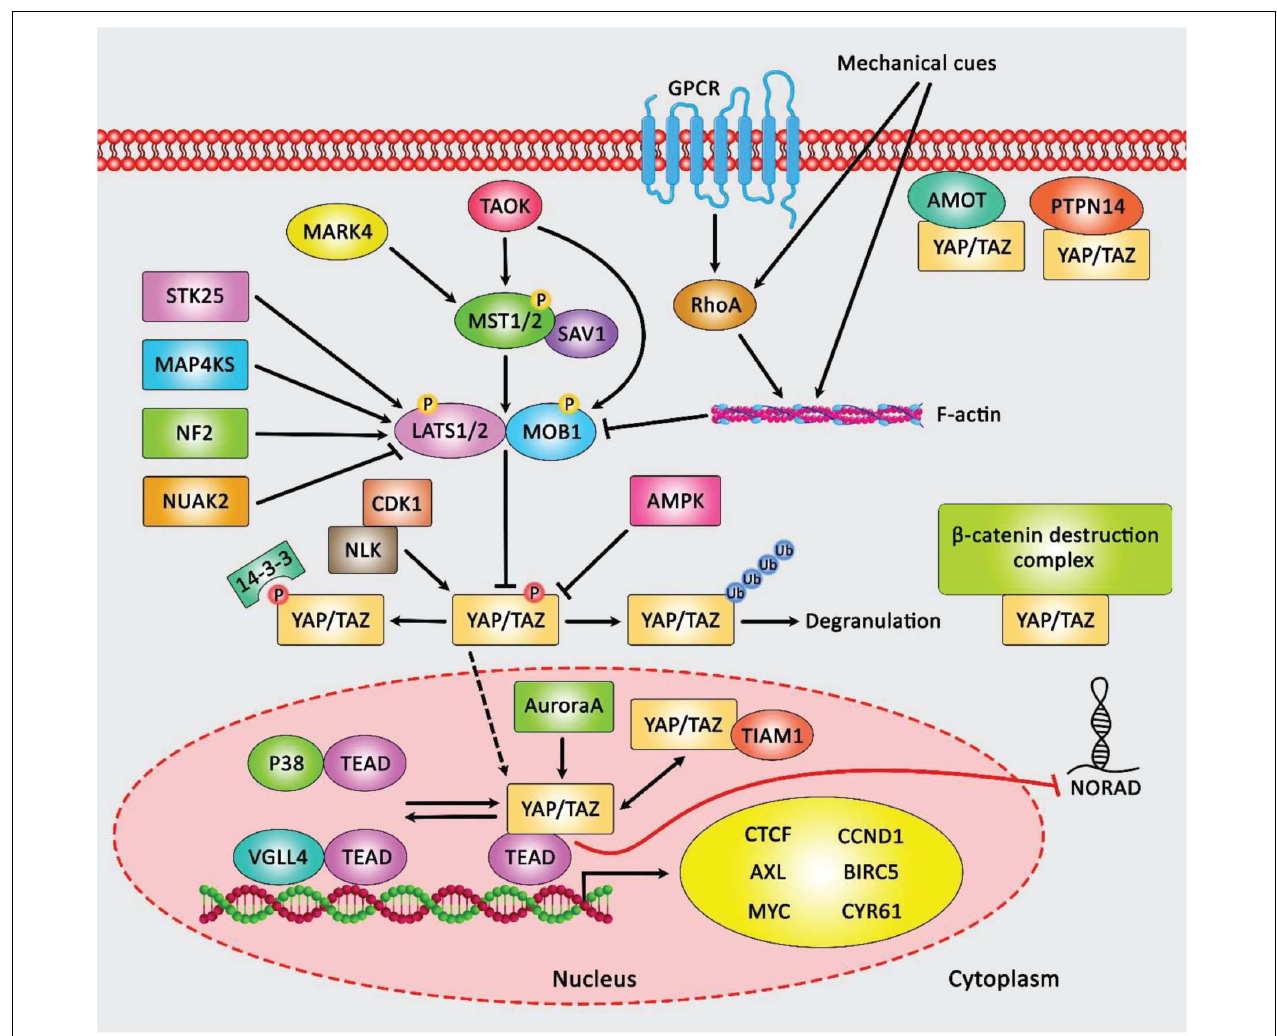
FIGURE 1 | A schematic representation of the crosstalk between Hippo signaling cascade and lncRNA NORAD in lung and breast neoplasms. YAP/TAZ is mainly modulated via the canonical Hippo cascade, MST1/2-SAV1, and LATS1/2-MOB1. LATS1/2 could in turn phosphorylate YAP/TAZ and suppress its function through either ubiquitination and proteasome-mediated degradation or 14-3-3-mediated cytoplasmic sequestration. Unphosphorylated YAP/TAZ is transferred to the nucleus, where it could interact with TEAD transcription factors and trigger the expression of various target genes. LATS1/2 could be upregulated via STK25, TAOK, NF2, and MAP4KS, while being inhibited through GPCR-RHOA-mediated F-actin function mechanical cues as well as NUAK2. In addition, expression of MST1/2 is regulated by TAOK and MARK4. Expression of YAP/TAZ is also modulated in an independent manner from LATS. Besides, PTPN14 and AMOT could interact with YAP/TAZ and sequester it in the cell membrane. Expression of YAP/TAZ is downregulated via the β -catenin demolition complex or TIAM1 through a direct interaction. Phosphorylation of YAP/TAZ is triggered by CDK1, AMPK, Aurora A, NLK, and various RTKs. In addition, p38 and VGLL4 could interact with TEAD and inhibit the function of YAP/TAZ (Yamaguchi and Taouk, 2020). Mounting evidence has collectively demonstrated that the Hippo pathway transducer YAP/TAZ-TEAD complex could play an effective role in suppressing the expression level of lncRNA NORAD in both lung and breast cancers. Its downregulation correlates with